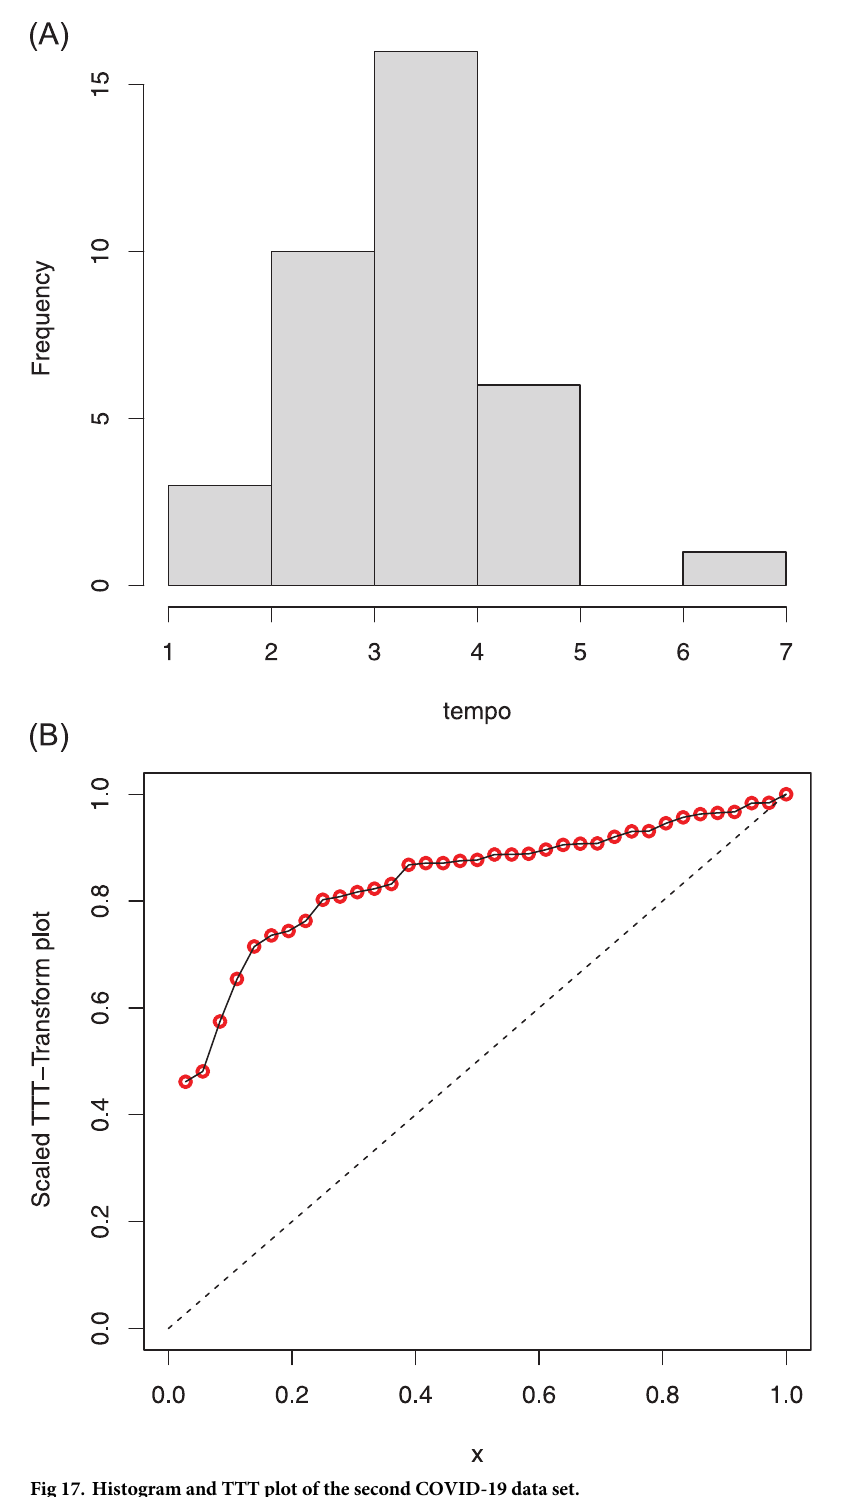
Fig 17. Histogram and TTT plot of the second COVID-19 data set.